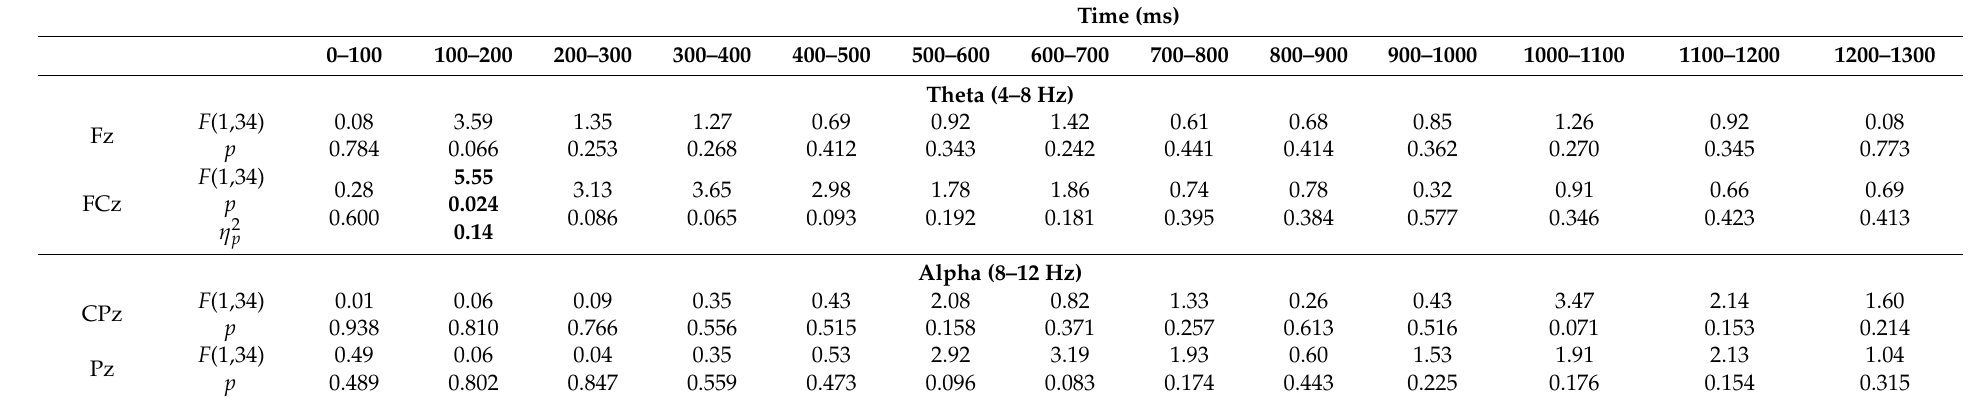
Table 3. Statistical Results for Main Effects of Group for Theta and Alpha Band Mean Power.